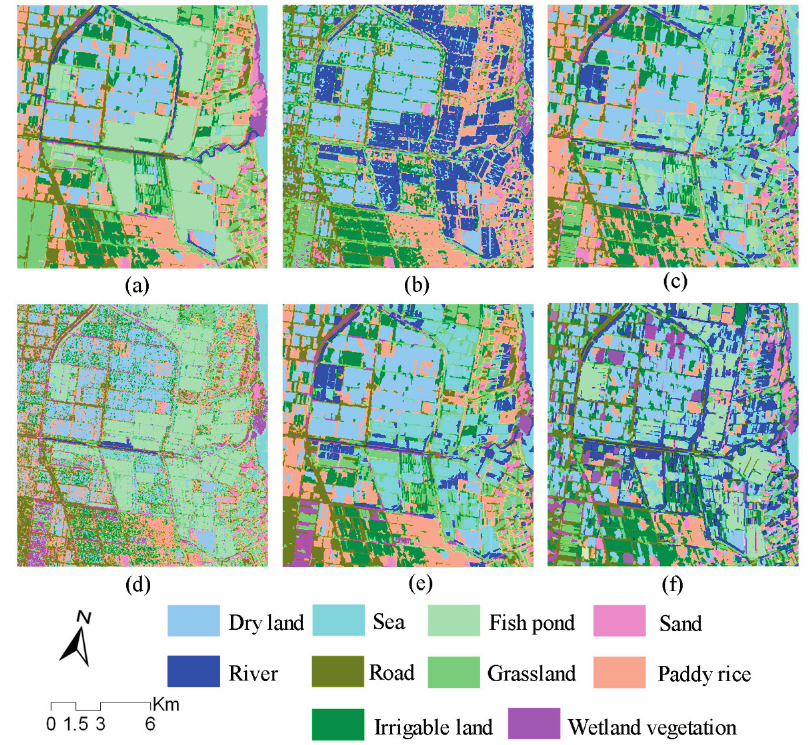
Figure 7. Classification results from: ( a ) the proposed method; ( b ) the Wishart supervised classification; ( c ) the proposed method without polarimetric parameters; ( d ) the proposed method without an object-based segmentation; ( e ) the proposed method without textural and geometric information; and ( f ) the proposed method using the nearest neighbor classifier instead of the decision tree